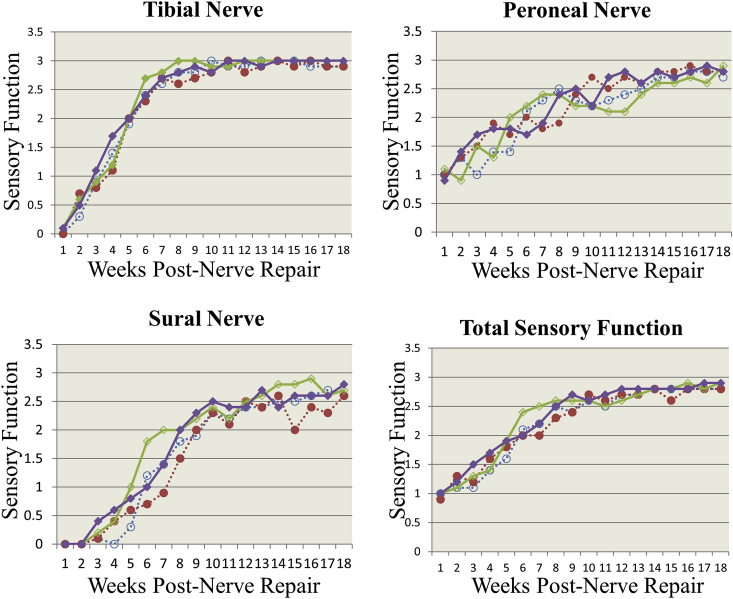
Sensory Function Assessment: Sensory function was assessed by pinch technique in the territories of the tibial, peroneal, sural and saphenous nerves as described, previously [39, 40] Withdrawal/vocal response was scored in comparison to the naive contralateral limb (0 = no response, 1 = slight, 2 = moderate, 3 = normal). The sensory score was assessed in individual nerve repair (INR) and sciatic nerve repair (SNR) models in the vehicle (control) and mesenchymal stem cell (MSC) treatment groups up to 18 weeks post-nerve repair. Peroneal nerve function was recovered first followed by tibial and sural nerves. Total (overall) sensory function which is the average of all four nerve boundaries (peroneal, tibial, sural and saphenous) was not significantly different (P > 0.05) between vehicle and MSC treated groups. However, sensory function recovery was slightly better in the MSC group than in the vehicle group. Solid square = INR MSC treatment (n = 10); Empty square = INR Vehicle control (n = 12); Solid circle = SNR MSC treatment (n = 9); and Empty circle = SNR Vehicle control (n = 12).